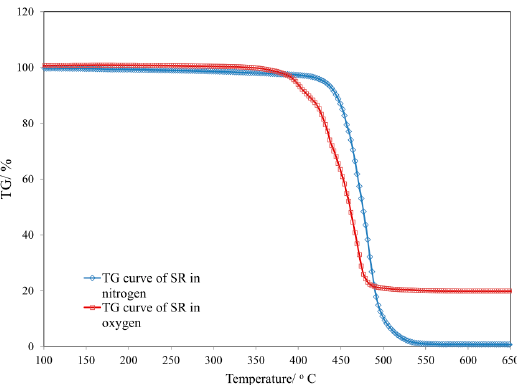
Figure 1. TG curves of silicone rubber in the air and nitrogen atmosphere.